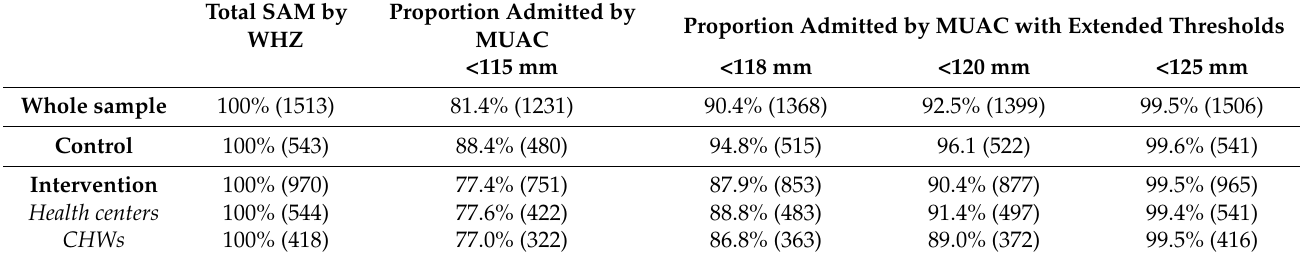
Figure 2. Sample distribution by anthropometric criteria for admission to treatment compared between groups. Table 3. Children classified as SAM by WHZ admitted to treatment in a MUAC-only